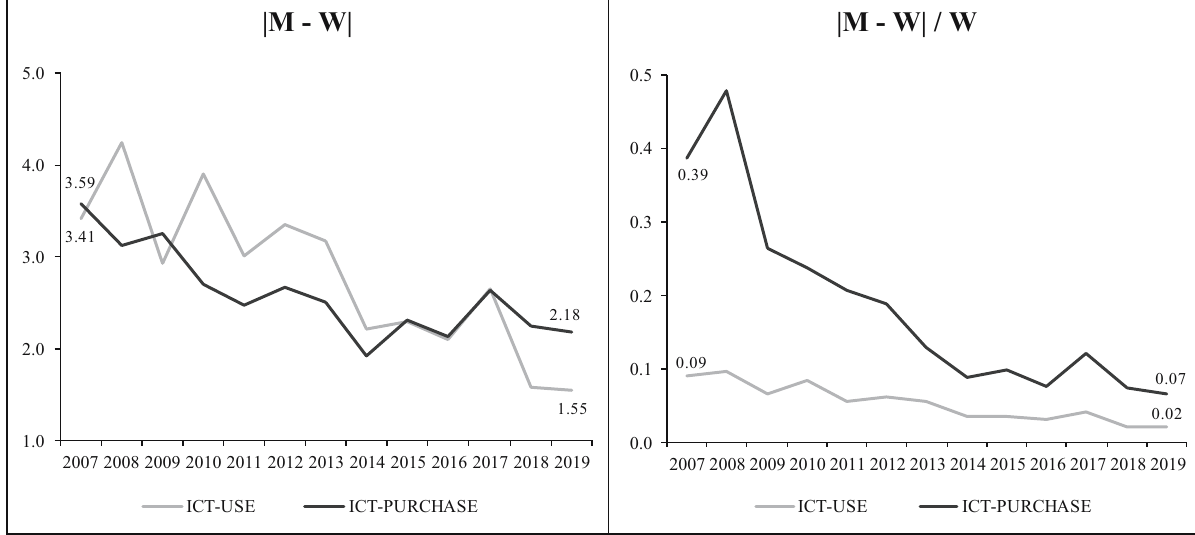
Figure 10: σ - convergence of the digital gender gap in the EU - 28, 2007 – 2019. Note: Evolution of the standard deviation. Source: Own elaboration from the Digital Economy & Society Database ( Eurostat )